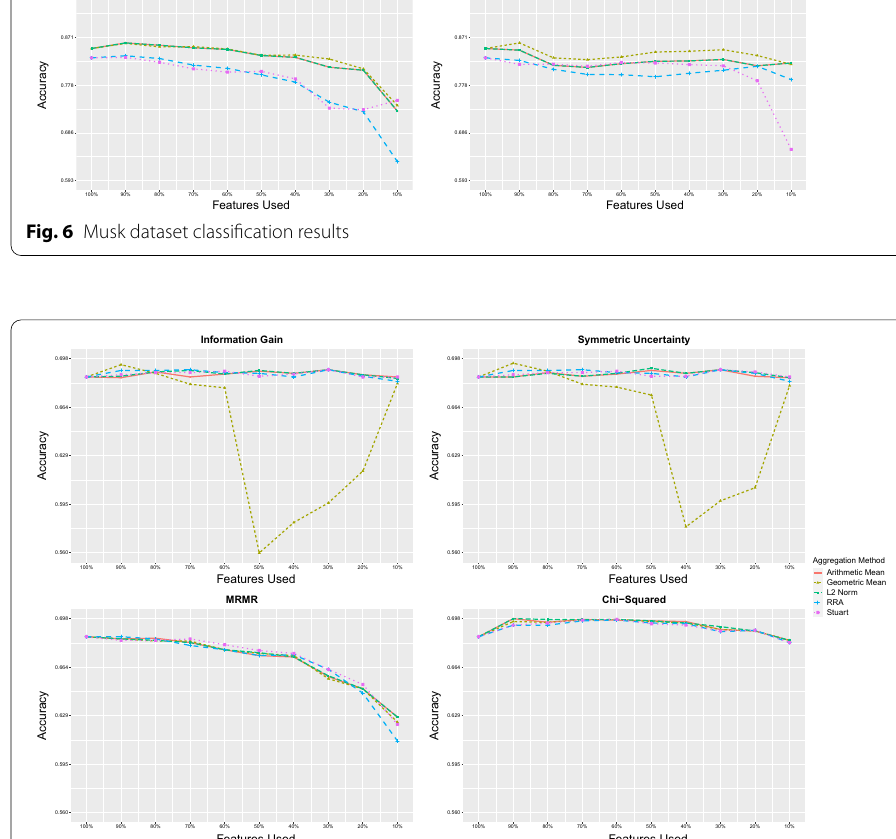
Fig. 7 Philippine dataset classification